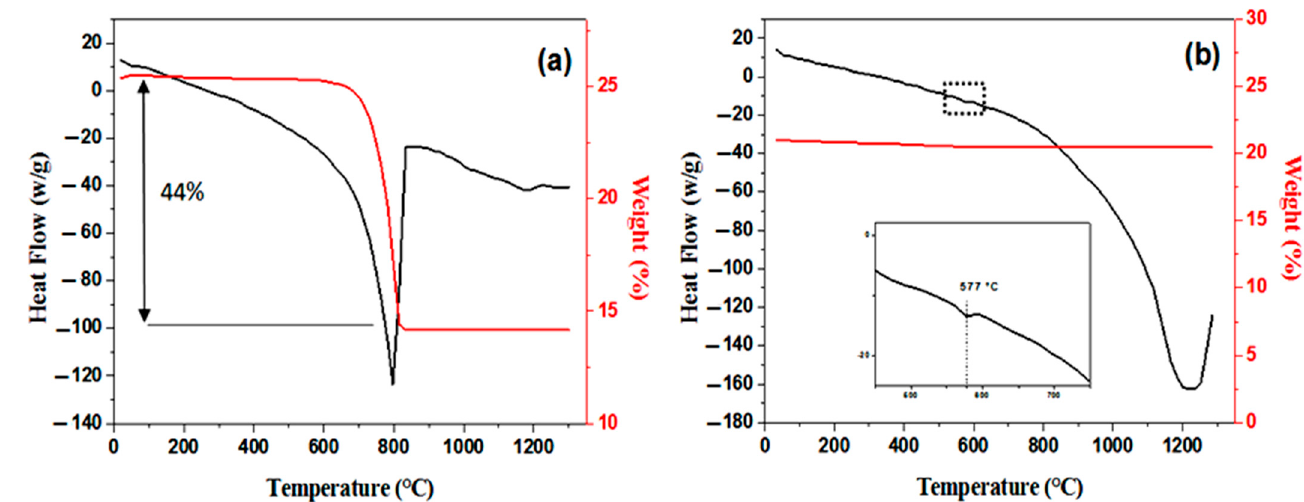
Figure 4. Thermal analysis curves (DSC and TGA) for ( a ) CC powders and ( b ) SS.